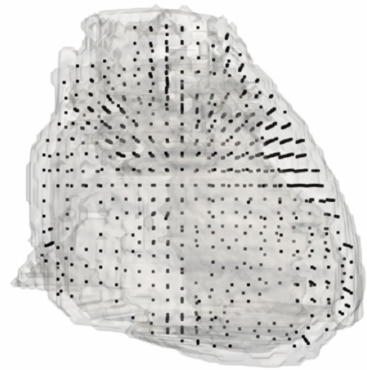
Figure 3. All points of forward problem analysis. The black dots represent the positions of the analysis points over a volume rendering of the TARO heart model.